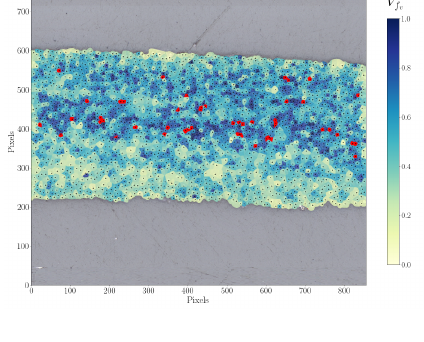
Figure 10. Two adjacent Voronoi analyses of tape A.